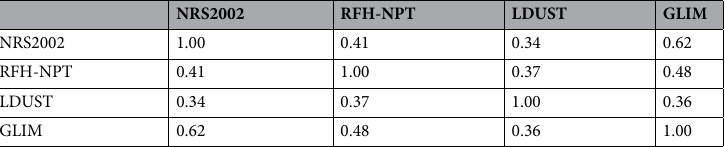
Table 3. Kappa coefficients of different tools. NRS2002 nutritional risk screening 2002, RFH-NPT royal free hospital-nutritional prioritizing tool, LDUST liver disease undernutrition screening tool, GLIM global leadership initiative for malnutrition.